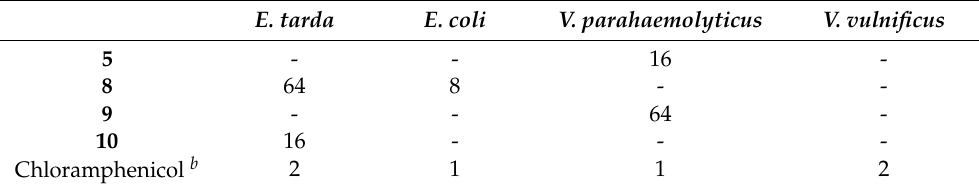
Table 4. Antibacterial activities of active compounds 5 and 8 − 10 (MIC, µ g/mL) a . E. tarda E.